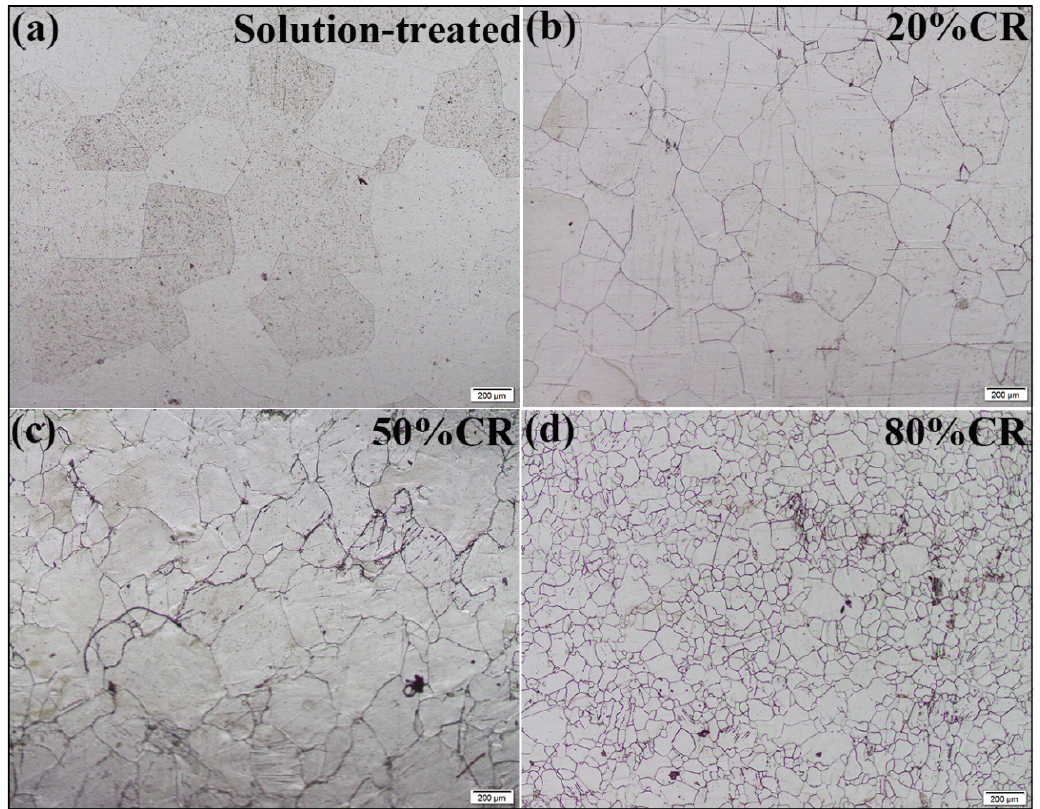
Figure 2. Optical micrographs of ( a ) the solution-treated sample, and ( b – d ) the cross-rolled samples with rolling reductions of 20%, 50% and 80%, respectively.